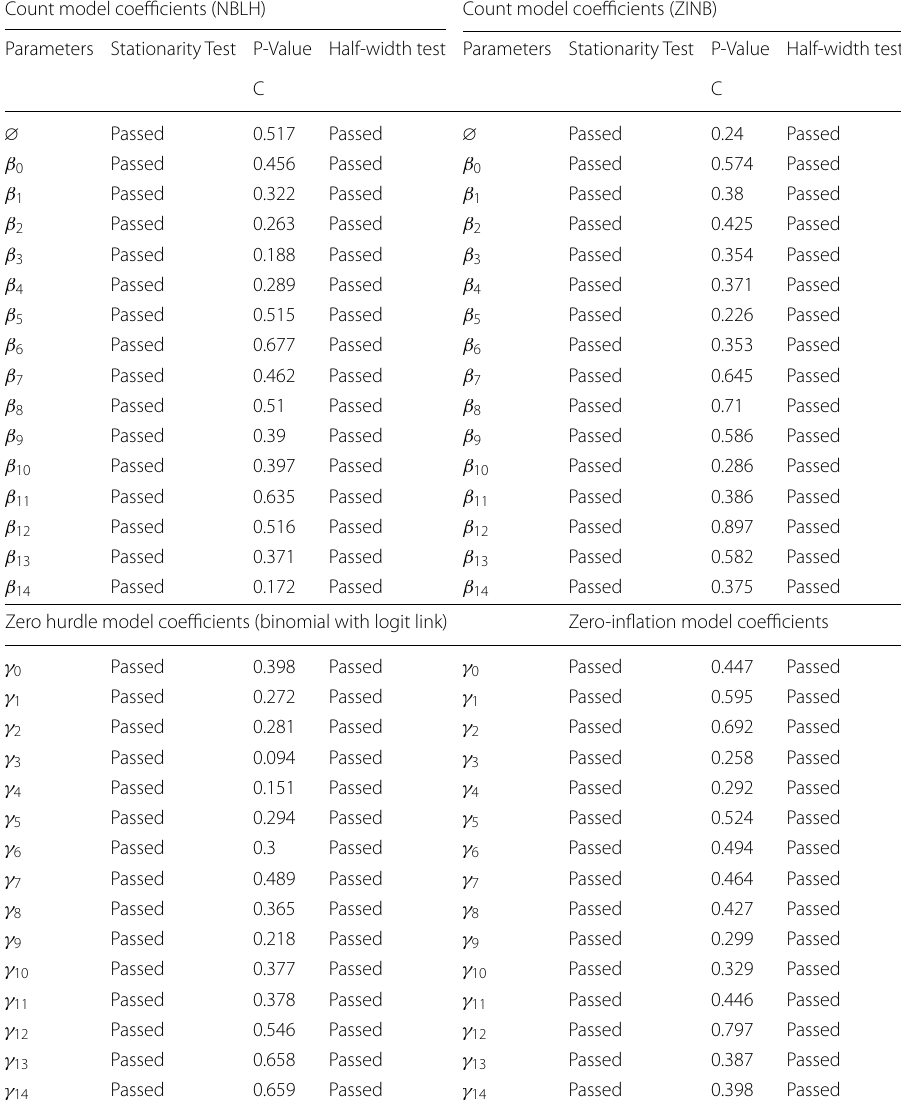
Table 3 Heidelberger and Welch Stationarity and half-width tests for the Bayesian chains used in the diagnosis of